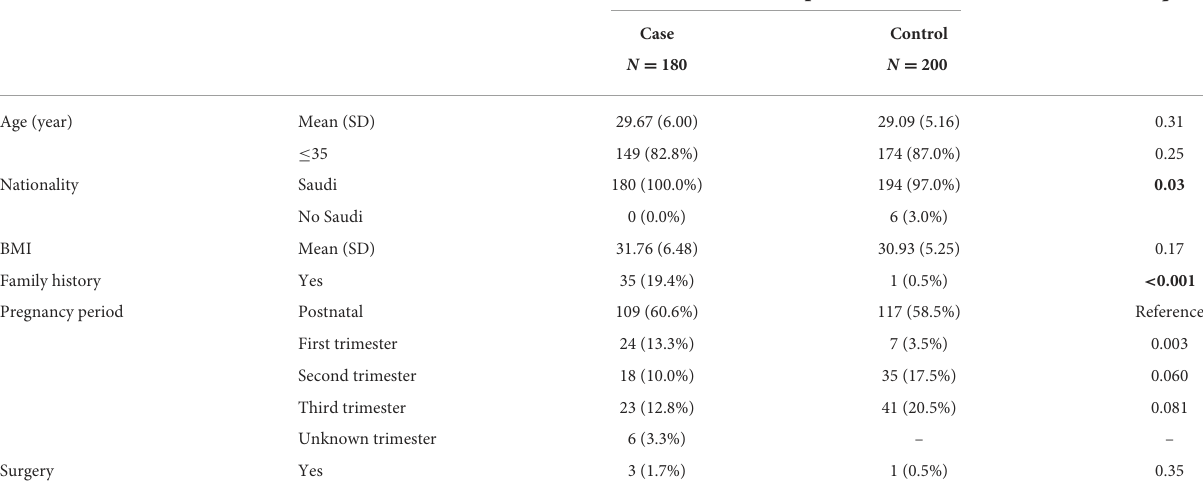
TABLE 1 Association between baseline characteristics and VTE in cases and